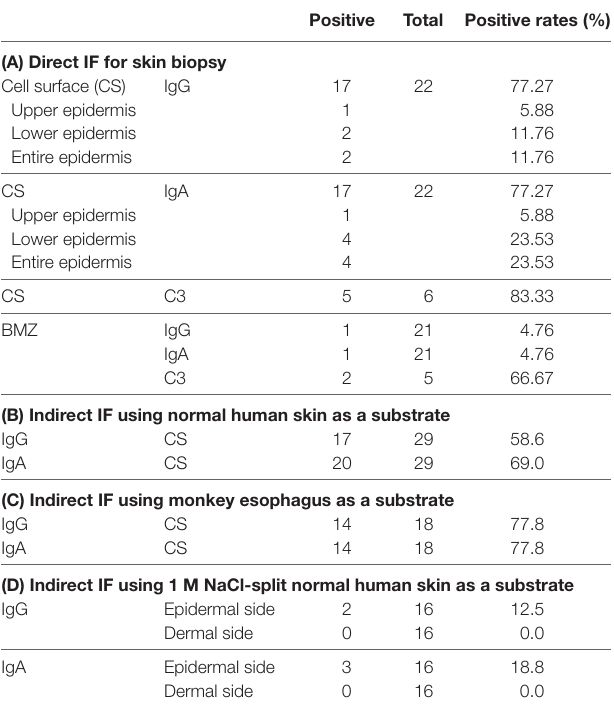
with various epidermal autoantigens for both IgG and IgA classes (Table S5 in Supplementary Material). For IgG antibodies, three cases each reacted with Dsg1 and Dsg3 and one case each reacted with both a and b forms of Dsc. One case each reacted with desmoplakin I, BP230, and envoplakin. For IgA antibodies, one case reacted with Dsg3 and two cases each reacted with both a and b forms of Dsc. The four cases with positive reactivity with BMZ in IF stud- ies were further examined by immunoblotting for the reactivity with various BMZ autoantigens. Two cases showed positive IgG, but not IgA, reactivity with BP180 NC16a domain RP, while none reacted with BP180 C-terminal domain RP for either IgG or IgA antibodies. One case was positive for IgG, but not IgA, for the 120-kDa LAD-1 in concentrated culture supernatant of taBLe 1 | Results of various immunofluorescence (IF) studies. HaCaT cells. No positive reactivity was found in immunoblotting positive total positive rates (%) of both purified human laminin-332 and normal human dermal extracts for either IgG or IgA antibodies.